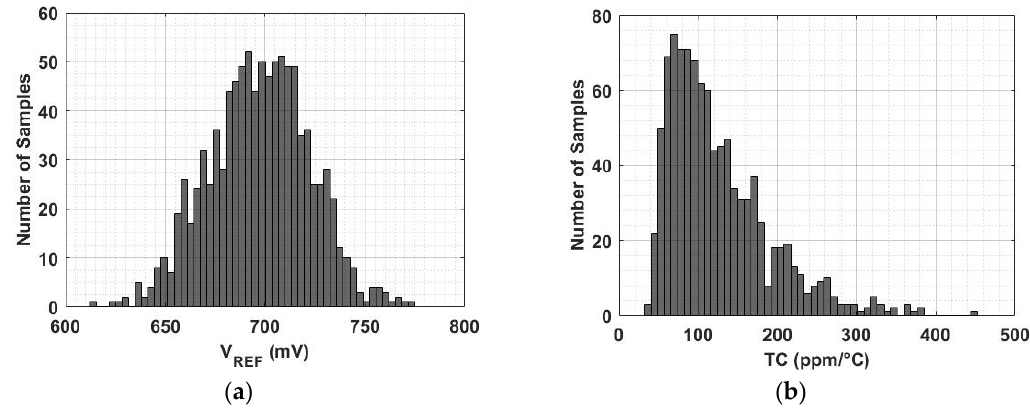
Figure 11. Histogram of ( a ) V REF and ( b ) the TC of V REF.